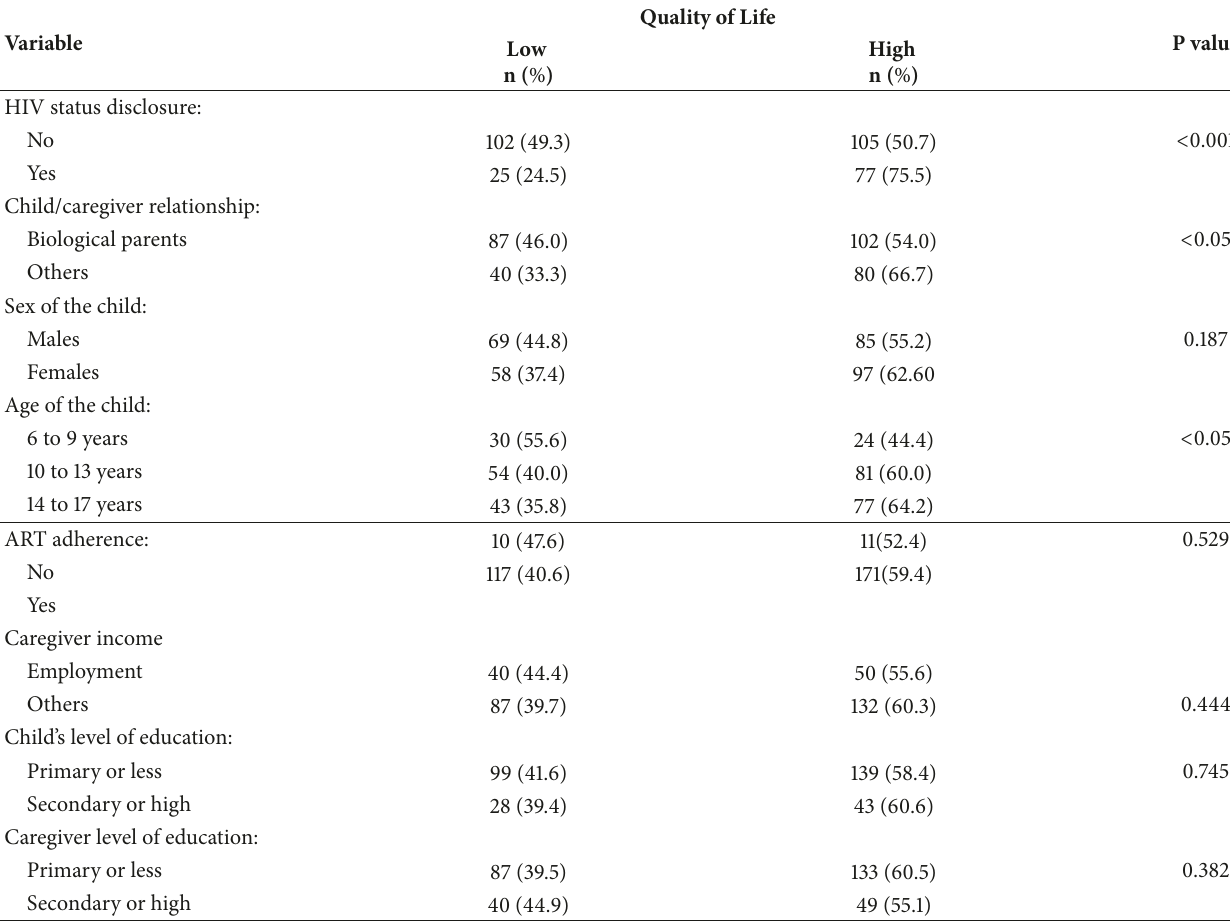
Table 6: Relationship between HIV status disclosure and quality of life, among children between 6 and 17 years on antiretroviral therapy, in Southern Highlands Zone, Tanzania (N=309) Chi square.